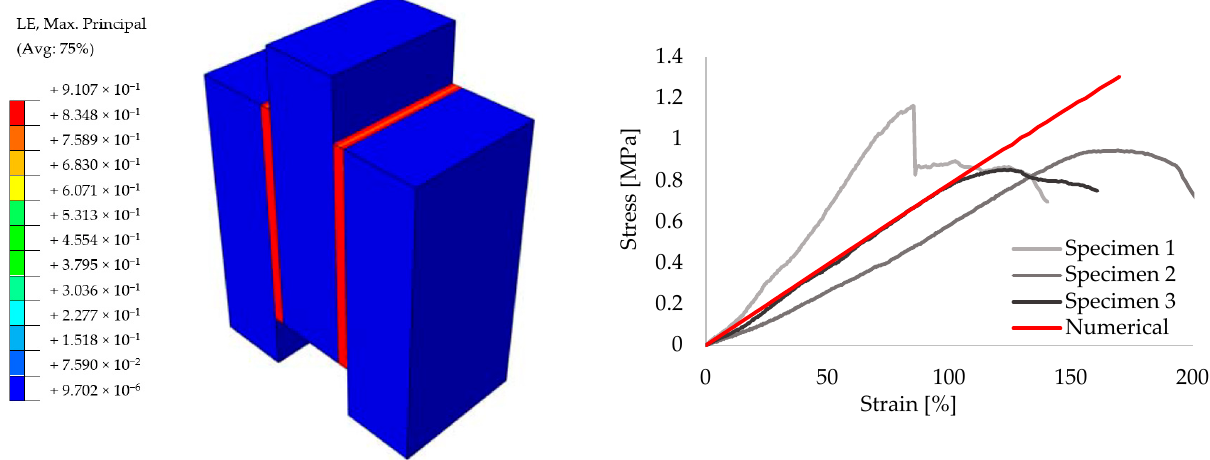
Figure 15. Shear results for the small size specimens with PolyUrethane PM: true strain diagram ( left ) and comparison of the numerical and experimental tests ( right ).